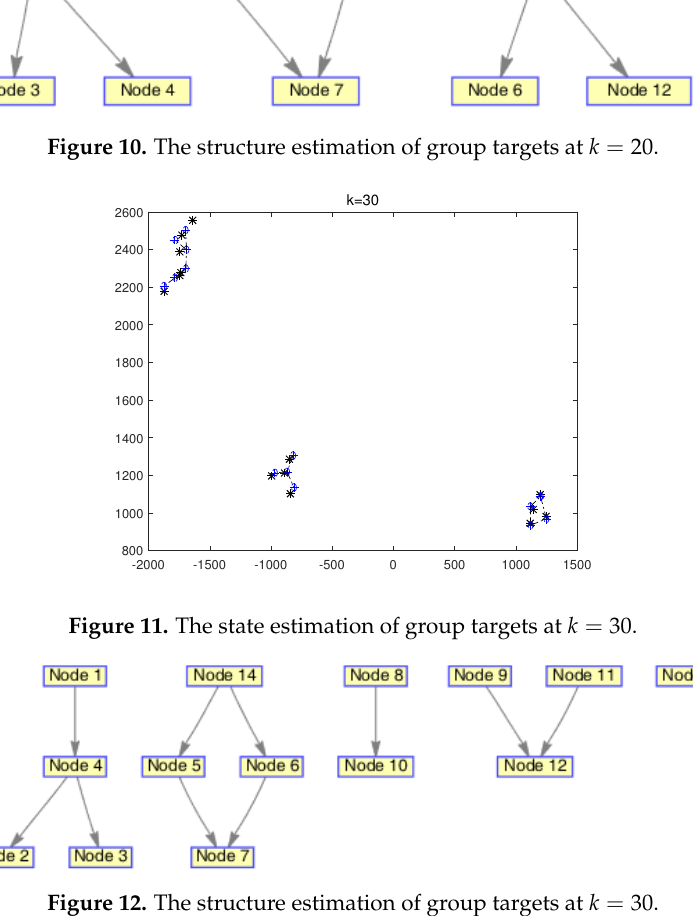
Figure 12. The structure estimation of group targets at k =